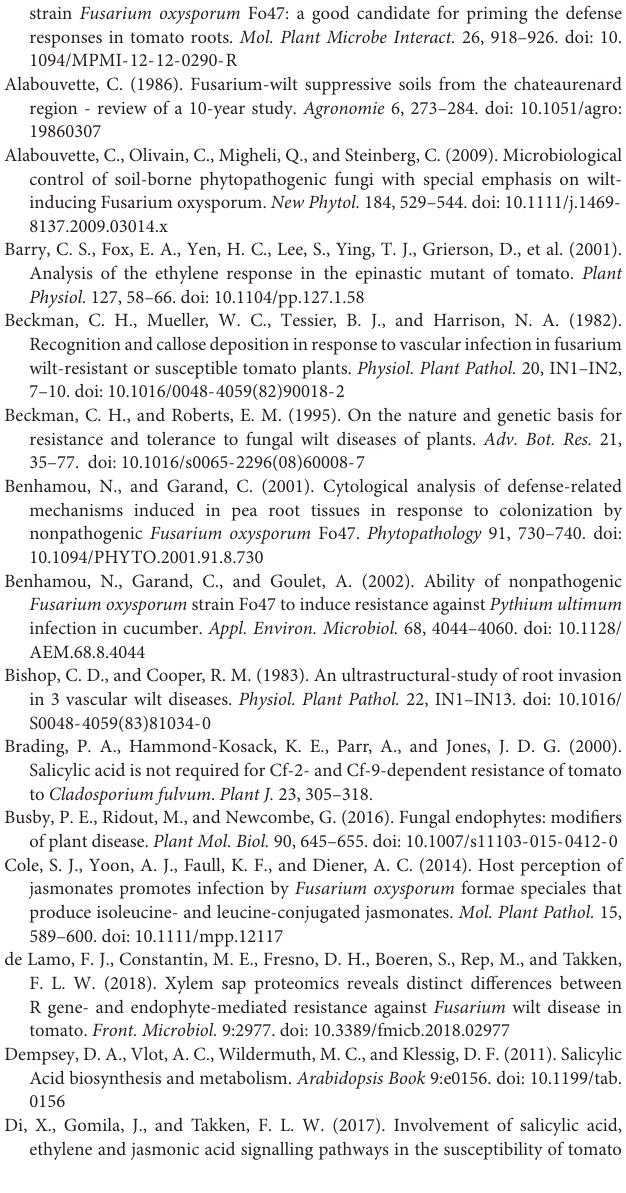
different letters represent a significant difference at P < 0.05 as determined by ordinary one-way ANOVA with Tukey’s multiple comparisons test. FIGURE S2 | Representative pictures showing callose deposition in mock, Fo47-GFP, Fol4287-RFP or co-inoculated tomato roots. Pictures were taken using the Digital Inverted Fluorescence EVOS Microscope (magnification 10 × ) using the bright field, DAPI filter for visualizing callose depositions, GFP filter for visualizing GFP-labeled Fo47, and Texas Red filter for visualizing RFP-labeled Fol4287. Merged pictures were obtained by composing the image in Fiji (Image J), of the blue (DAPI), red (Texas Red), and green (GFP) channels. Scale bar = 100 µ m. Mock ∗ depicts an example of a root that has only few callose depositions, while the Mock panel below shows another root from the same plant with a high number of depositions. TABLE S1 | Primer sequences used for RT-qPCR